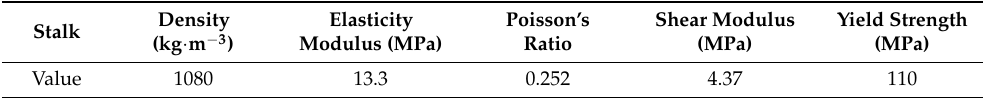
Table 2. Physical characteristics of a castor stalk.